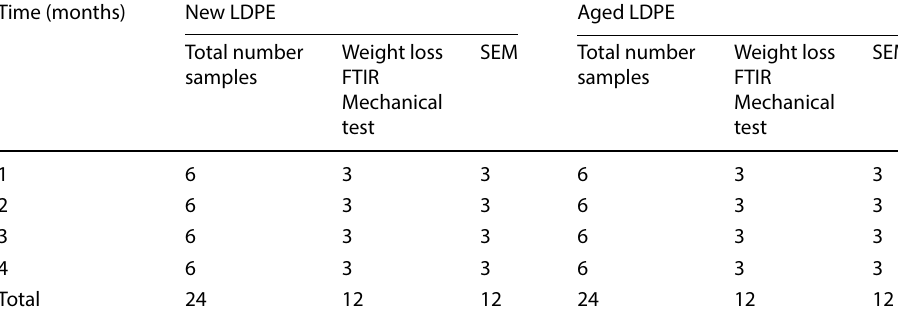
Table 1 Sampling design for LPDE characterization during